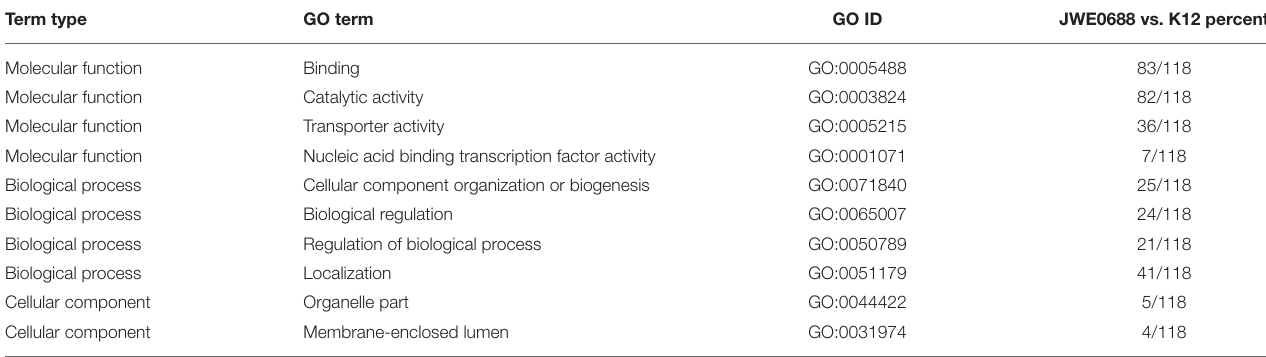
TABLE 4 | GO categories for the down-regulated proteins in E. coli JW0688.